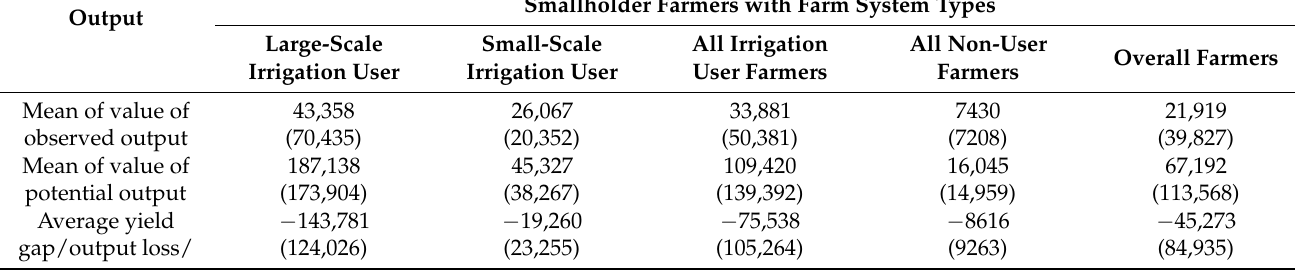
Table 5. Yield gap due to technical (in)efficiency.